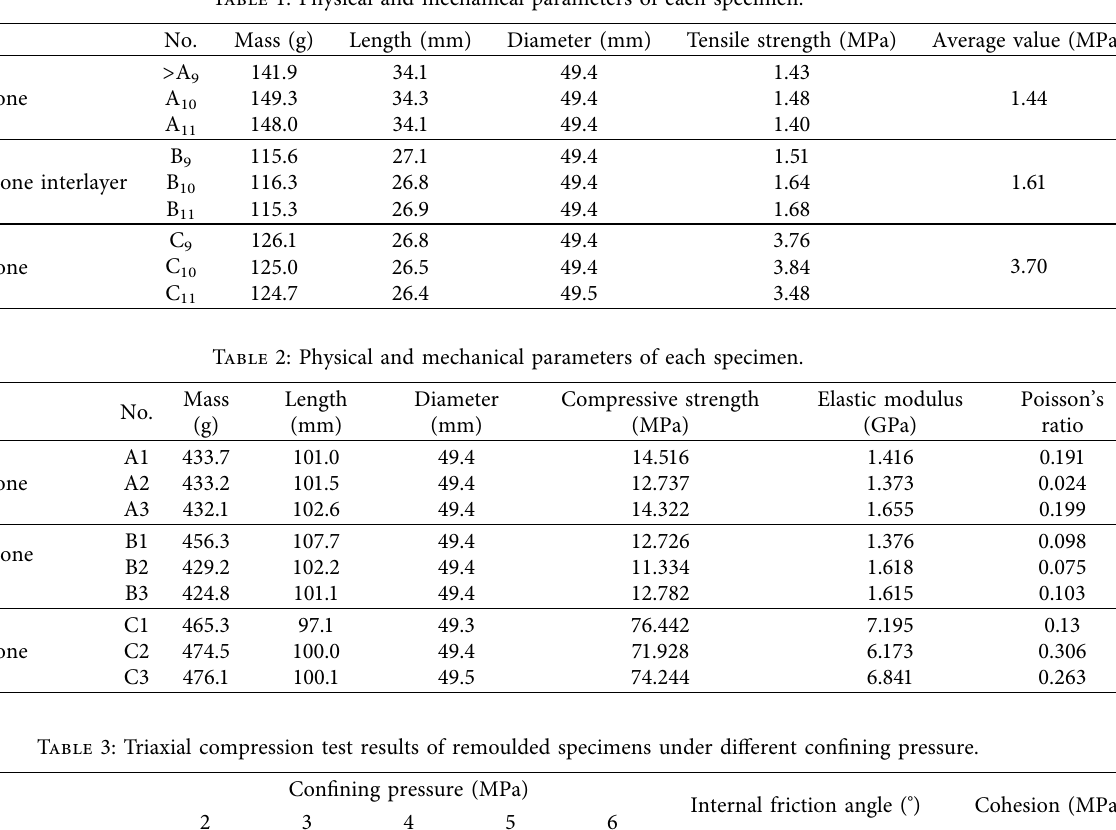
Table 1: Physical and mechanical parameters of each